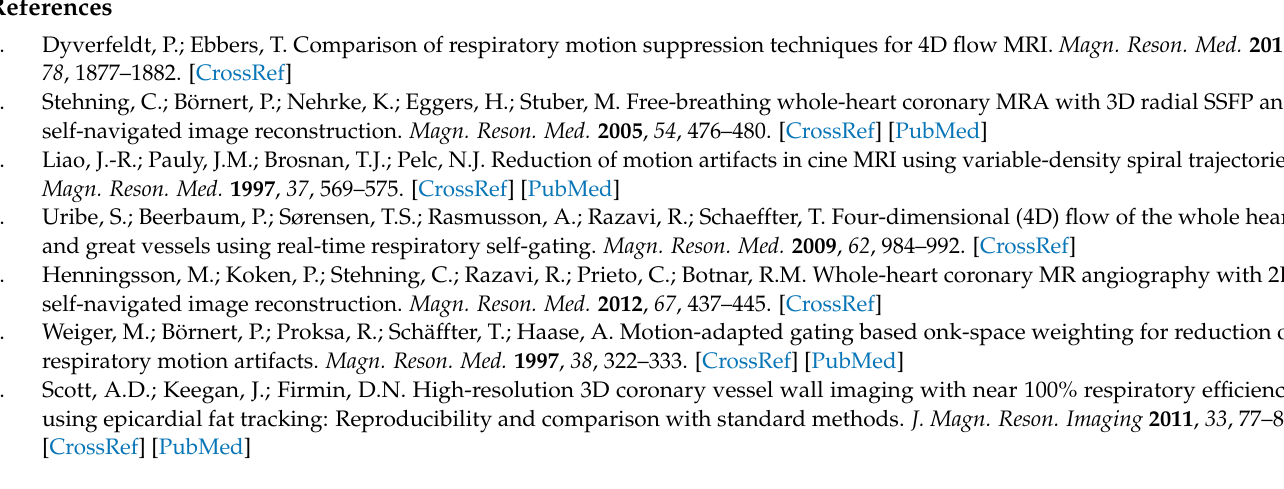
. The differ- (cid:2870)